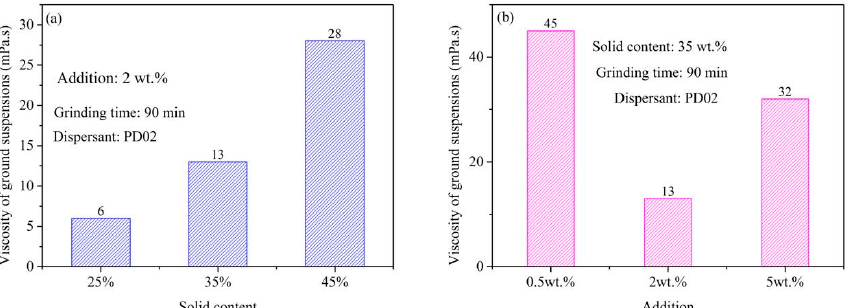
Figure 8. The viscosity of ground suspensions at ( a ) different solid contents; ( b ) with different addition amounts of dispersant PD02.